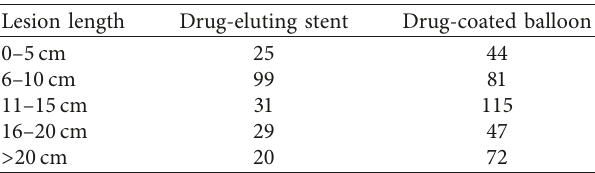
Table 2: Lesion lengths compared between drug-eluting stents and drug-coated